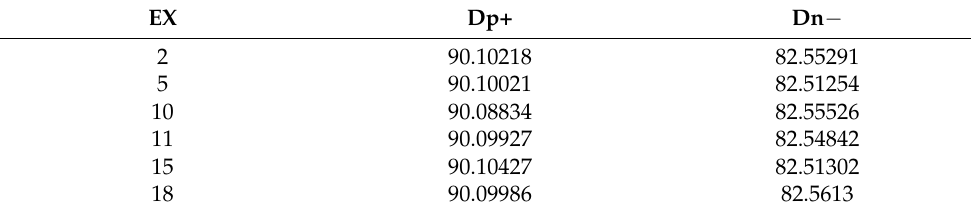
Table 11. Distance measures of alternatives from ideal